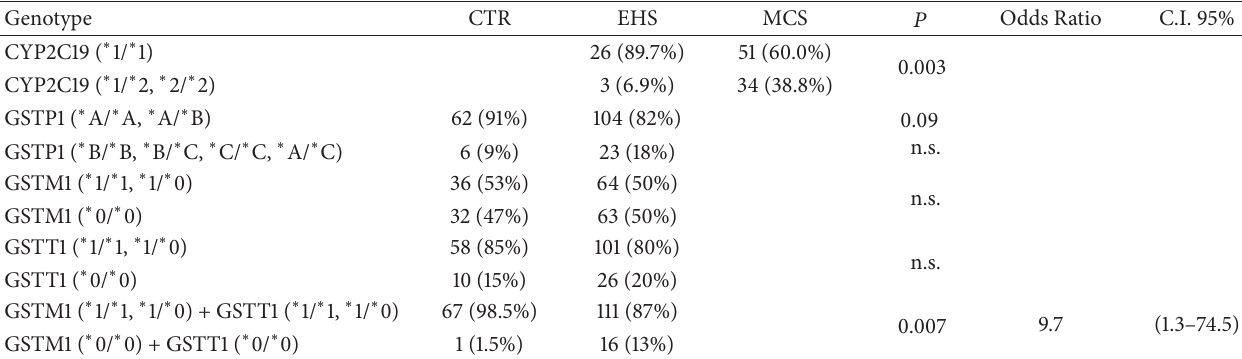
Table 1: Statistical analysis of genotype distribution of cytochrome P450 (CYP) isoenzymes in EHS-patients self-reporting electromagnetic hypersensitivity ( 𝑛 = 29 ) versus MCS-multiple chemical sensitivity patients without EHS ( 𝑛 = 85 ) and of glutathione S-transferase P1 (GSTP1), glutathione S-transferase M1 (GSTM1), and glutathione S-transferase T1 (GSTT1) isoenzymes in CTR-healthy control subjects ( 𝑛 = 68 ) versus EHS-patients ( 𝑛 = 127